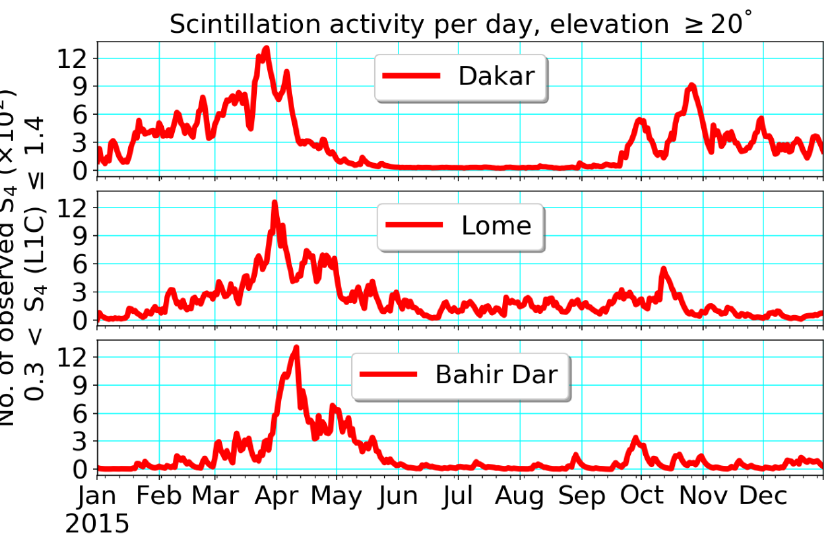
Figure 2. Number of scintillation events recorded with a 50 Hz receiver in Bahir Dar, Lomé and Dakar during